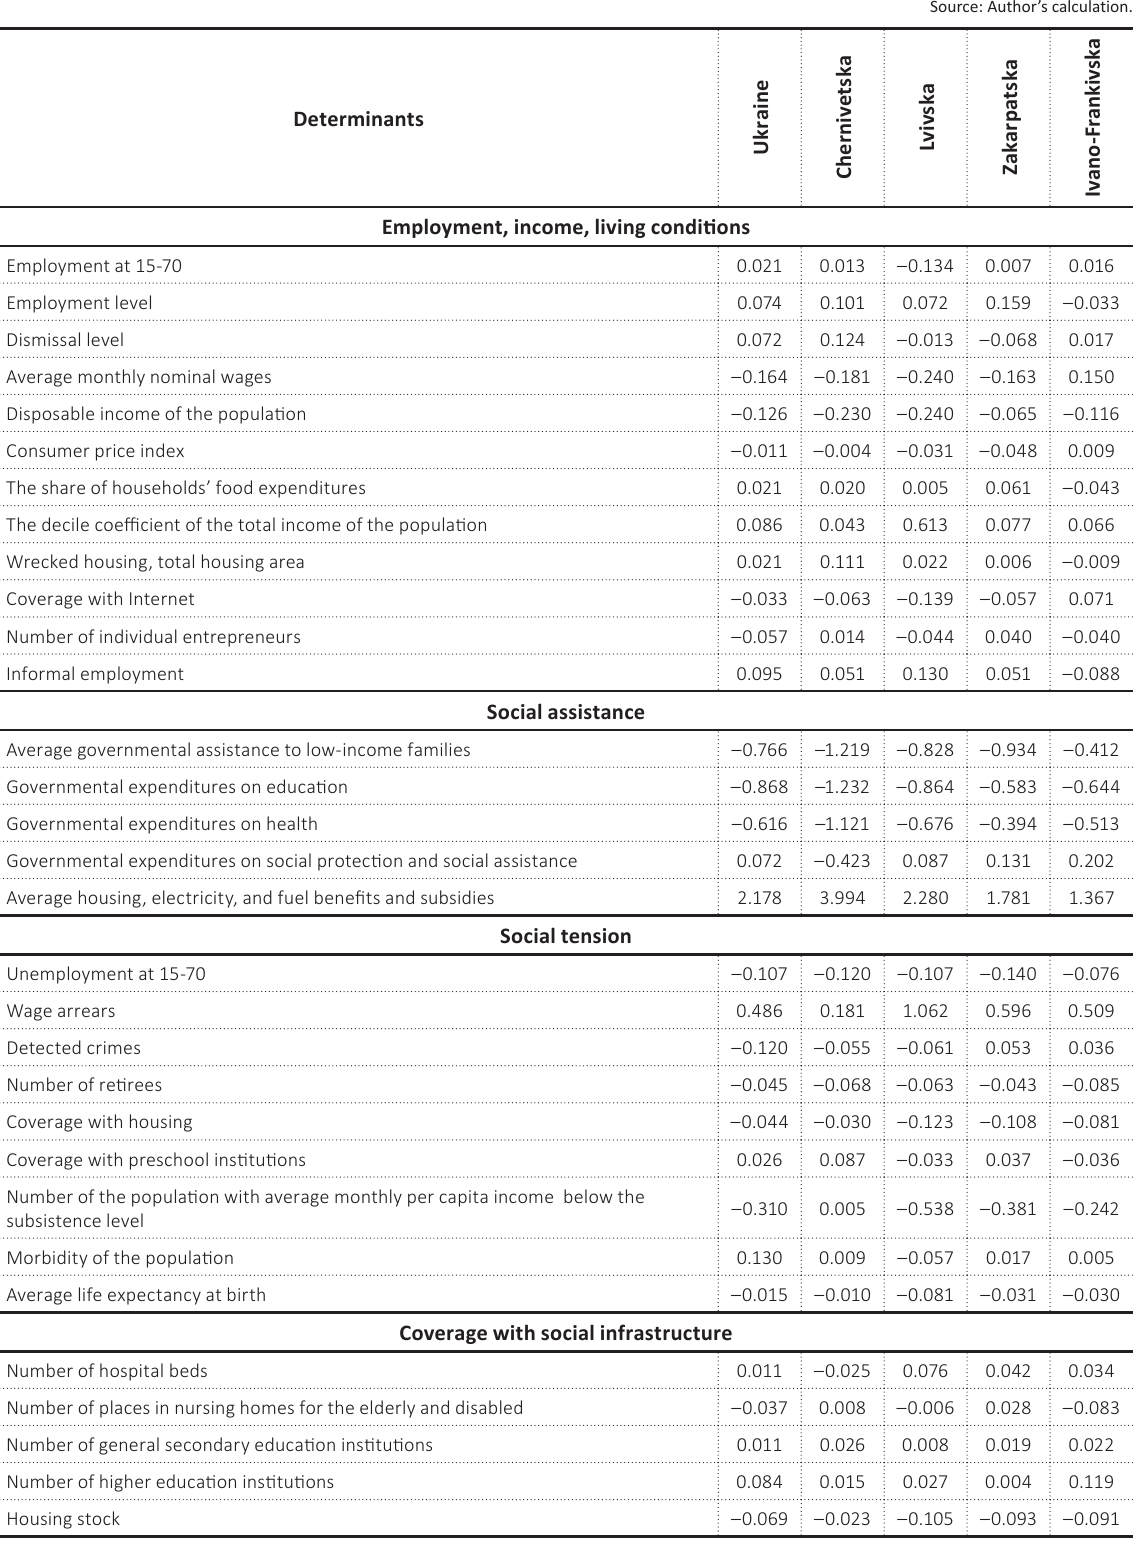
Table B1. Average growth paces of the weight coefficients of social resilience environment determinants in the Carpathian region, 2010–2019,